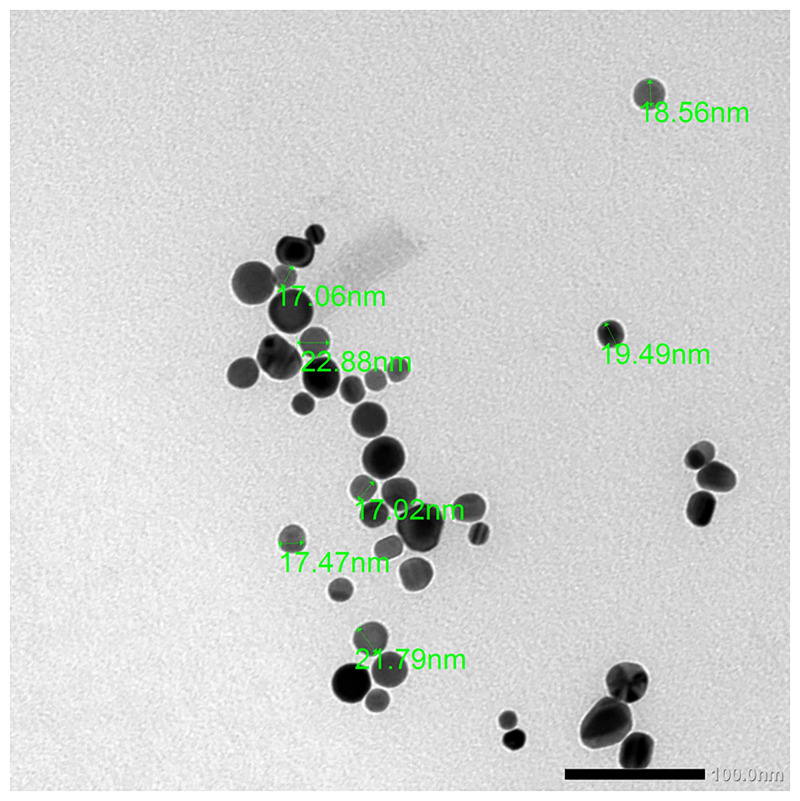
Transmission electron micrograph of Au-NPs.